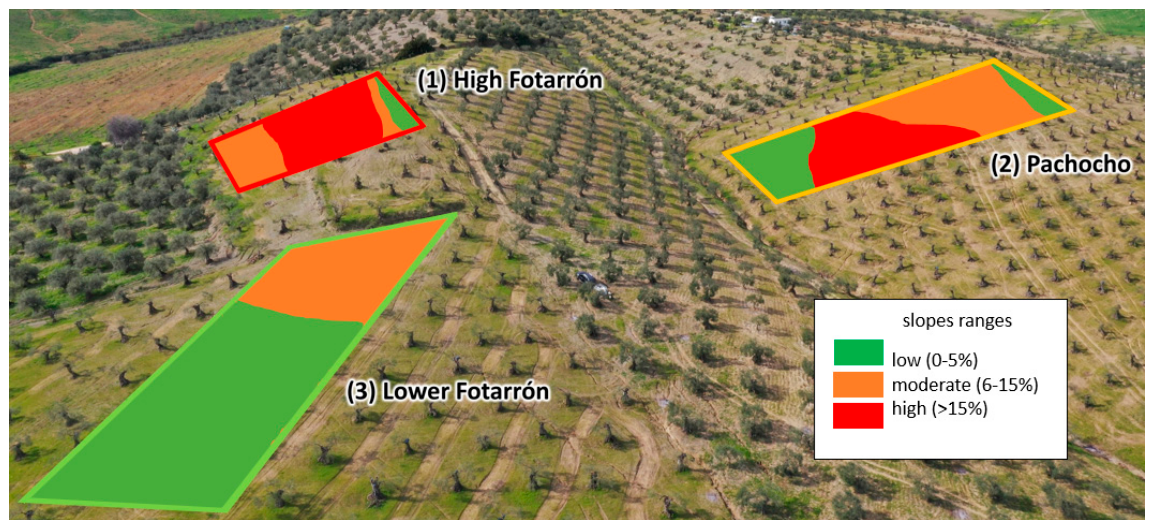
Figure A2. Slope ranges from low (0–5%), moderate (6–15%) to high (>15%) for each analyzed.